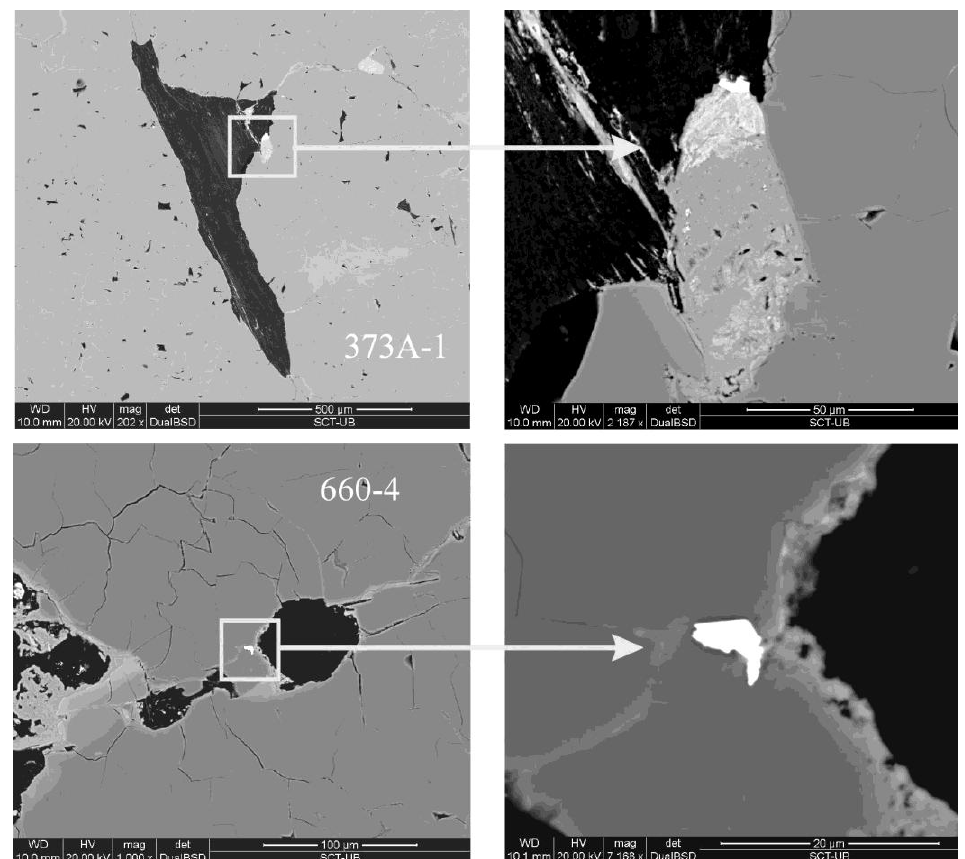
Figure 13. Paragenetic assemblages of Pt-Fe and Os-Ir alloys in the CHR-2 chromitite (BSE images). 373A-1: Large kaolinite lamella veined with Fe-hydroxides; a small grain of Pt-Fe alloy is located at the contact between kaolinite and a composite aggregate of Fe-hydroxide; an ilmenite crystal located along the fracture is visible in the NE corner of the large-field picture. 660-4: Pt-Fe alloy located in ilmenite at the contact with enclosing chromite 1; ilmenite occurs in a fracture with kaolinite and Fe-hydroxide; 661-1: Composite grain of Pt-Fe (light grey) and Os-Ir (white) alloys in Fe-hydroxide at the rim of a large kaolinite lamella; kaolinite is spotted and coated with botryoidal Fe-hydroxide; 660-9: Large grain of Os-Ir alloy at the rim of a large aggregate of Fe-hydroxide, located at the junction of frac tures in chromite